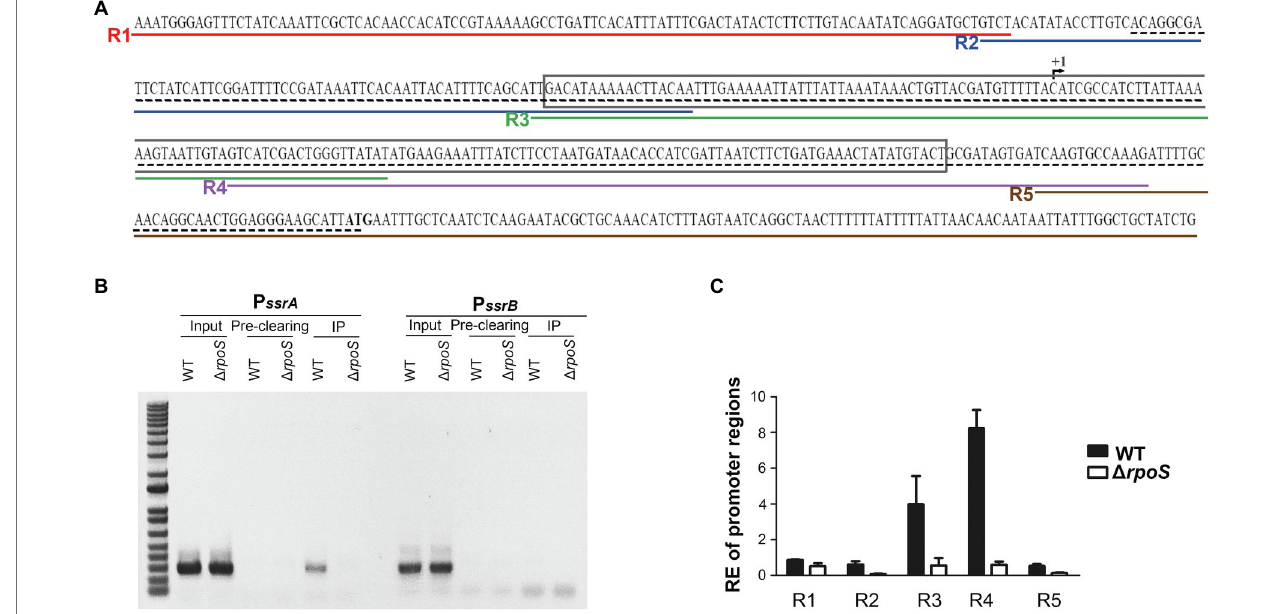
FIGURE 5 | Binding of σ S to the ssrA promoter. (A) Scheme for Chromatin immunoprecipitation (ChIP)-PCR and ChIP-quantitative PCR (qPCR). The +1 site of ssrA transcription is indicated with a broken arrow and its start codon is in bold. The region amplified by ChIP-PCR is underlined with a black dashed line and that amplified and used in electrophoretic mobility shift assay (EMSA) is boxed. Five regions amplified in ChIP-qPCR are underlined in different colors: R1 in red by primers R1-F and R1-R, R2 in blue by primers R2-F and R2-R, R3 in green by primers R3-F and R3-R, R4 in purple by primers R4-F and R4-R, and R5 in brown by primers R5-F and R5- R. (B) DNA-protein cross-links were fixed in Salmonella wild-type and Δ rpoS mutant strains using formaldehyde. DNA fragments bound to σ S were immunoprecipitated using anti-RpoS antibody and subjected to PCR using primers specific to the P ssrA (PssrA-ChIP-F/R) and P ssrB (PssrB-ChIP-F/R) regions. Input total DNA and pre-clearing (DNA non-specifically bound to Protein A/G agarose) were analyzed in parallel. The ChIP-PCR products were separated by 1% agarose gel electrophoresis. (C) DNA fragments precipitated in IP and pre-clearing were used as templates in ChIP-qPCR using five different primer sets (R1-F/R, R2-F/R, R3-F/R, R4-F/R, and R5-F/R). Enrichment of the P ssrA region with σ S was relatively computed using the following formula: relative enrichment (RE) = 2 − ( ∆ Ct IP −∆ Ct Pre-clearing) , where ∆ Ct IP is Ct P ssrA − Ct gyrB for the IP samples and